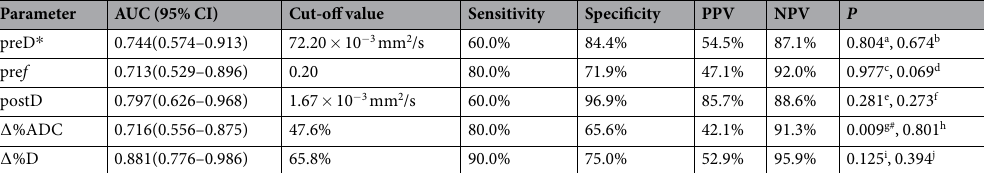
Table 4. Diagnostic efficacy of the IVIM-DWI parametric values in the differentiation between the pCR and non-pCR groups. # Significance before multiple comparison correction, but not significant after correction; IVIM-DWI, intravoxel incoherent motion diffusion-weighted imaging; pCR, pathological complete response; non-pCR, non-pathological complete response; ADC, apparent diffusion coefficient; D, pure diffusion coefficient; D * , pseudo-diffusion coefficient; f , perfusion fraction; AUC, area under the curve; CI, confidence interval; PPV, positive predictive value; NPV, negative predictive value; a preD * vs pre f , b preD * vs postD, c pre f vs ∆ %ADC, d pre f vs ∆ %D, e pre f vs postD, f postD vs ∆ %D, g ∆ %ADC vs ∆ %D, h preD * vs ∆ %ADC, i preD * vs ∆ %D, j postD vs ∆ %ADC.